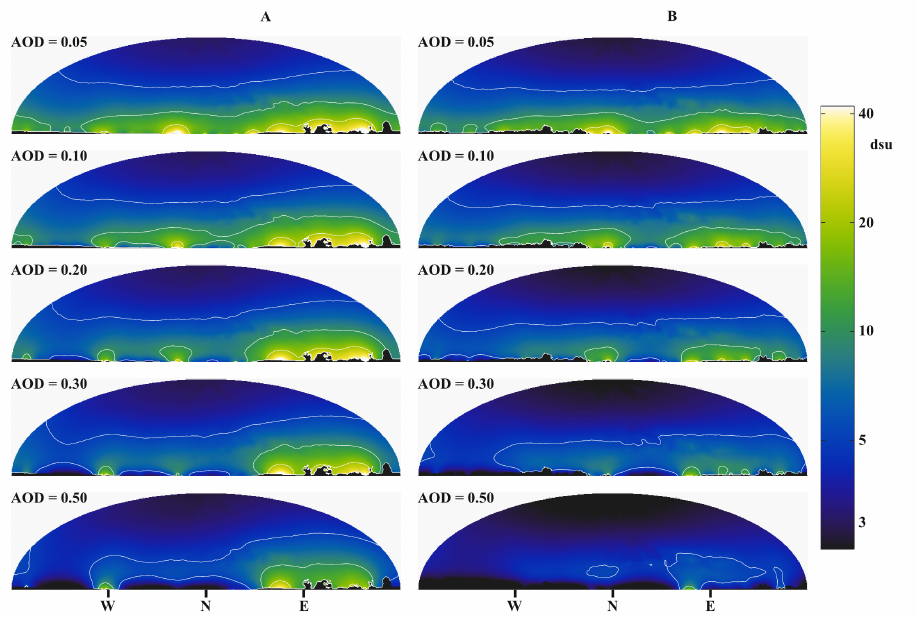
Figure 13. The dependence of the sky radiance map on the atmospheric optical depths (AOD) for two different sites. ( A ): standard observing site; ( B ): location close to